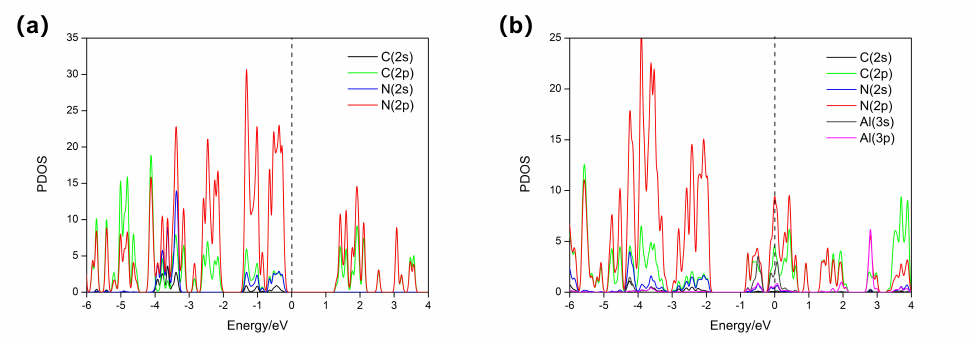
Figure 3. ( a , b ) The PDOS of the pristine g-CN and Al-doped g-CN for selected N, C, and Al atoms. The energy was plotted with respect to the Fermi energy.